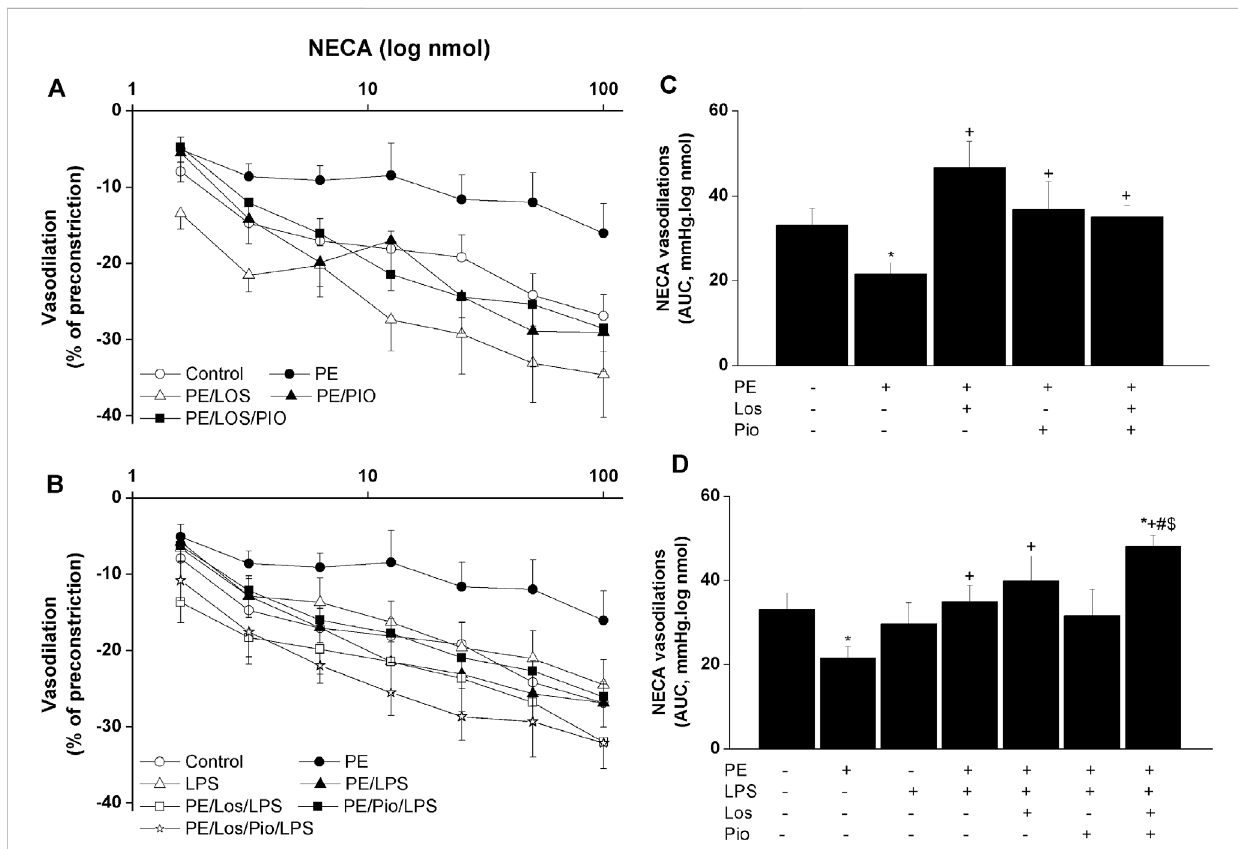
FIGURE 5 Effect gestational losartan and/or pioglitazone therapy on cumulative vasodilatory dose response curves of NECA (panels A, B ) and AUCs (panels C, D )oftheNECA vasodilatorydose responsecurveinphenylephrinepreconstrictedisolatedperfused kidneysinmale offspringofPEorPE/LPS dams.Data are expressed as the mean ± SEM of 7-8 measurements. ANOVA followed by the Tukey ’ s post hoc was utilized to measure statistical signi fi cance. * p < 0.05 vs. “ Control ” , + p < 0.05 vs. “ PE ” , # p < 0.05 vs. “ LPS ” and $ p < 0.05 vs. “ PE/LPS ”